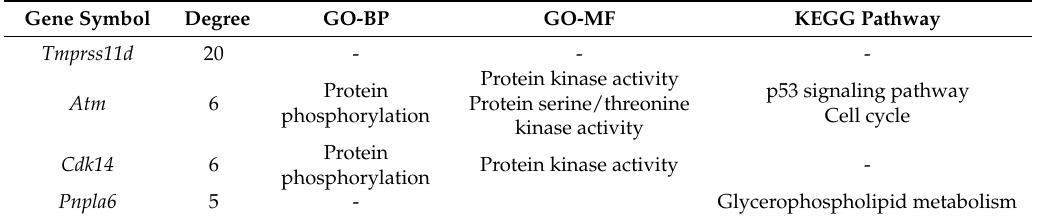
Table 2. Hub genes and the associated significant GO terms and KEGG pathways.